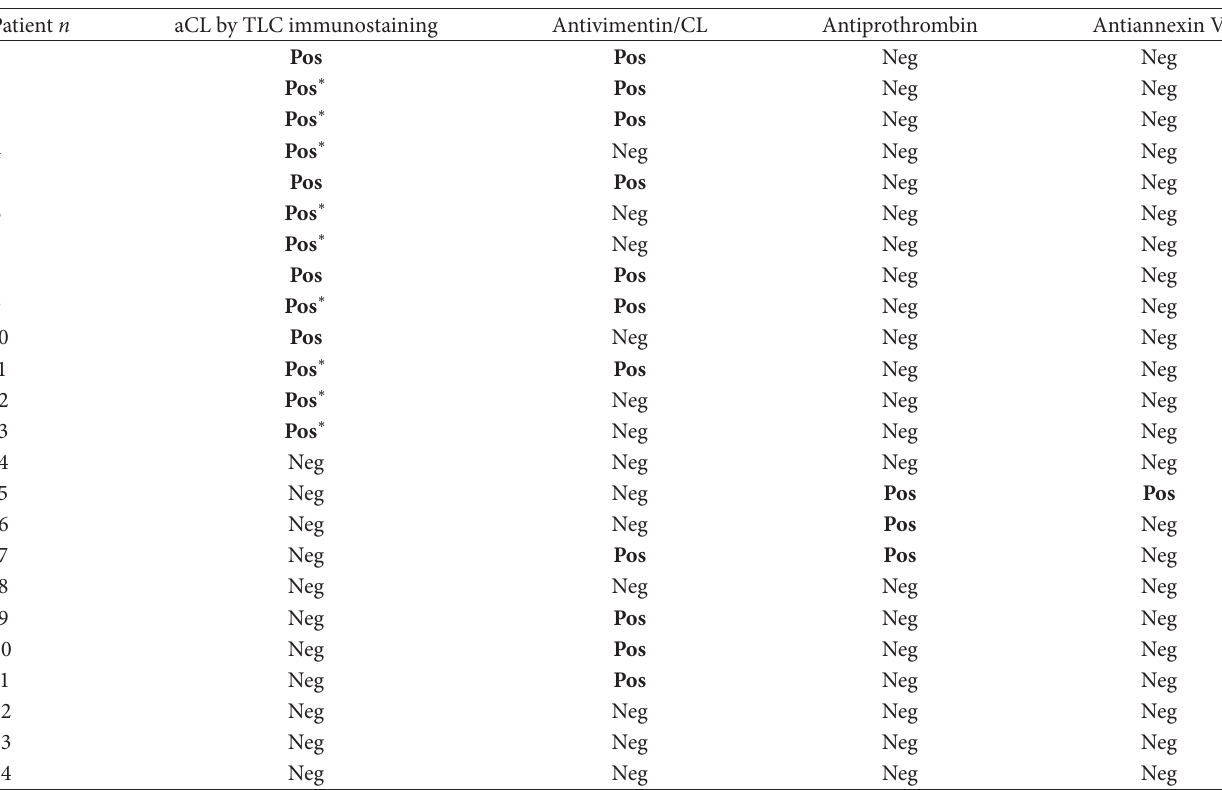
Table 3: Positivity of autoantibodies in the 24 SN-APS sera.